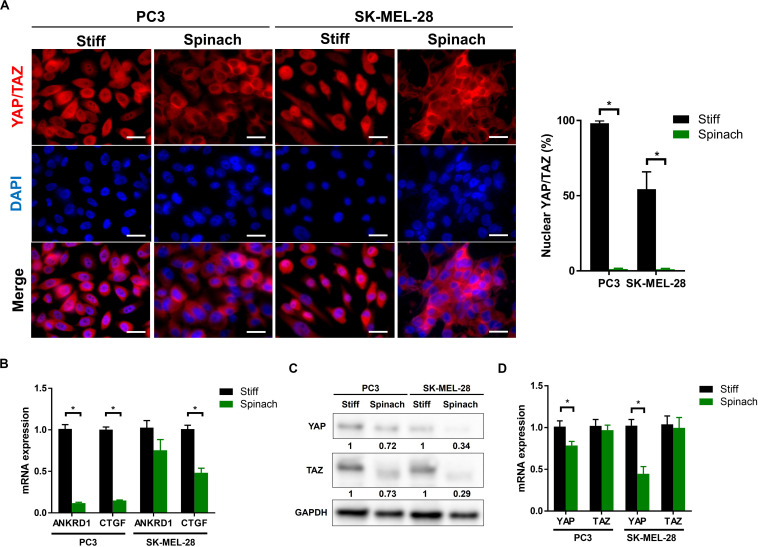
YAP/TAZ signaling pathway was downregulated in cells cultured on spinach leaf decellularized scaffolds. (A) Immunofluorescence images of YAP/TAZ and nuclei (DAPI) in PC3 and SK-MEL-28 cells seeded on coverslip and spinach scaffold for 3 days. Scale bars = 15 μm. Graphs indicate the percentage of cells with nuclear YAP/TAZ (n = 3, *p < 0.05; Student t-test). (B) Quantitative RT-PCR analysis in PC3 and SK-MEL-28 cells to measure YAP and TAZ mRNA levels. Cells were grown on TCPS or spinach scaffold for 3 days. Data were normalized to expression on TCPS and indicated as mean ± SEM (n = 3, *p < 0.05; Student t-test). (C) Immunoblotting of YAP and TAZ in PC3 and SK-MEL-28 cells seeded on TCPS and spinach scaffolds. Bands intensities were quantified using ImageJ and normalized with GAPDH. Numbers represent the expression level compared to TCPS of three independent experiments. (D) Quantitative RT-PCR for YAP/TAZ target genes (CTGF and ANKRD1) in PC3 and SK-MEL-28 cells. Cells were grown on TCPS or spinach scaffold for 3 days. Data were normalized to expression on TCPS and indicated as mean ± SEM (n = 3, *p < 0.05; Student t-test).